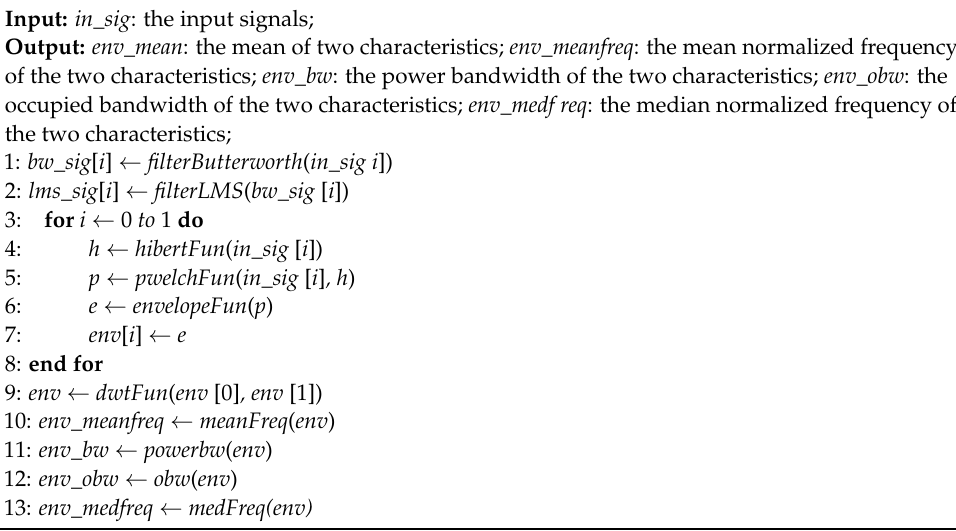
Algorithm 1 Ultrasonic Signals Articulation Feature Extraction